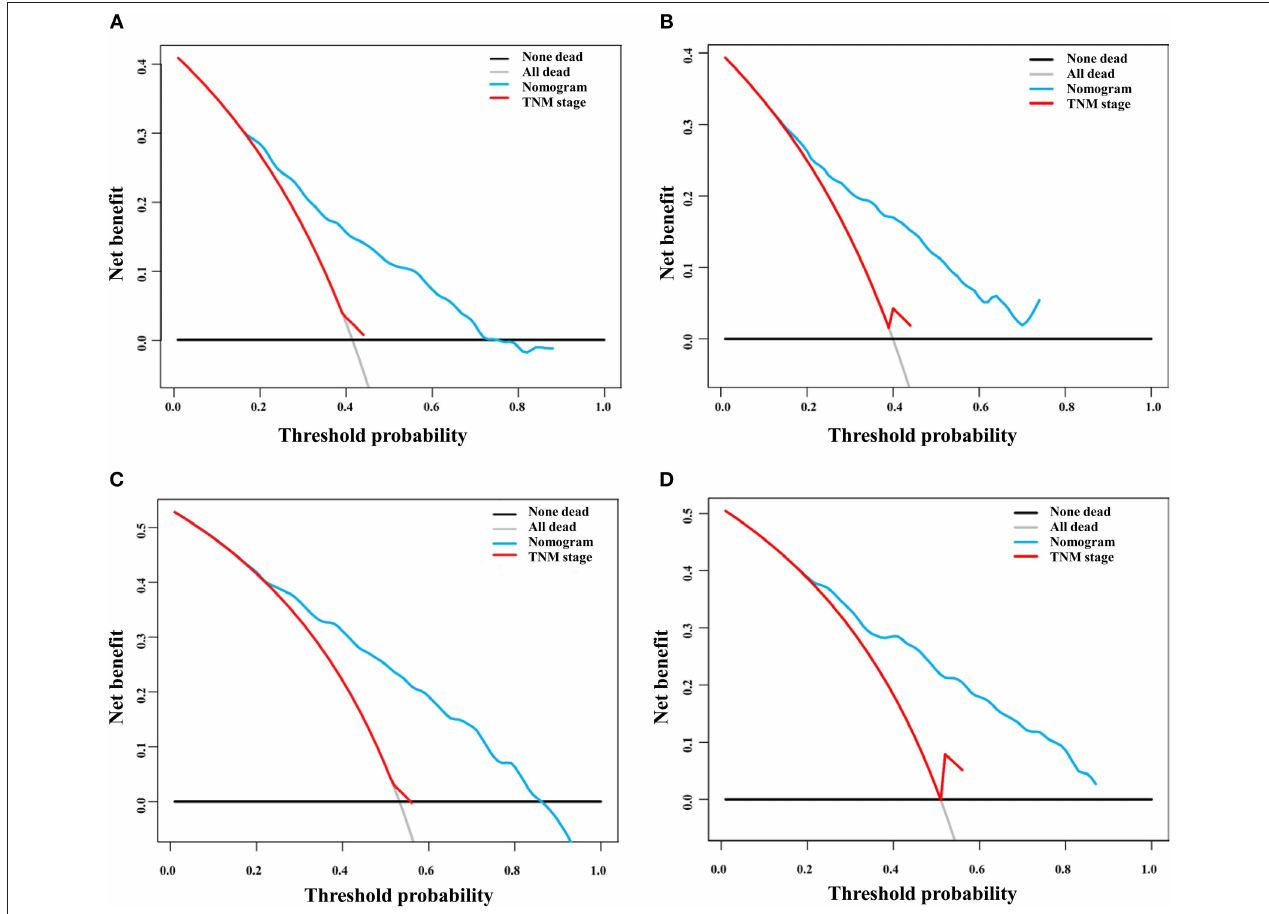
FIGURE 6 | Decision curve analysis of the nomogram and TNM staging system for the survival prediction of patients with early hepatocellular carcinoma. (A) Three-year survival in the training group. (B) Three-year survival in the validation group. (C) Five-year survival in the training group. (D) Five-year survival in the validation